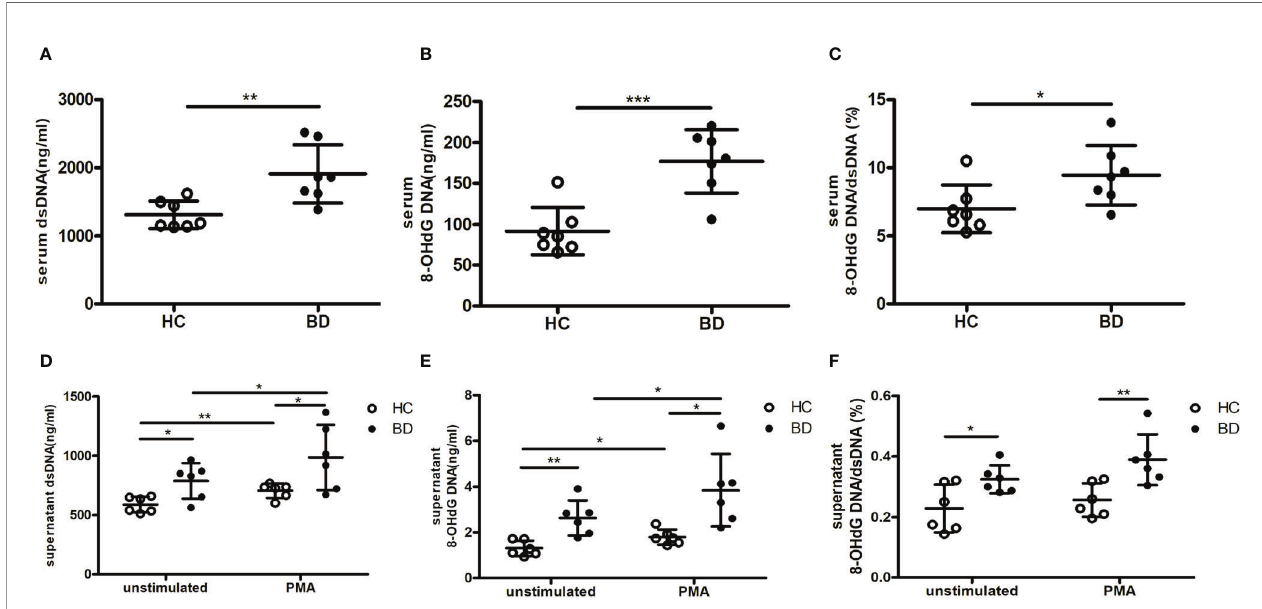
FIGURE 4 | BD neutrophil extracellular traps (NETs) contain more oxidized DNA. Serum (A) dsDNA and (B) 8-OHdG DNA from HC (n = 7) and BD (n = 7). (C) The percentage of 8-OHdG DNA in dsDNA from HC (n = 7) and BD (n = 7) serum. Supernatant (D) dsDNA and (E) 8-OHdG DNA produced by unstimulated and PMA- stimulated HC neutrophils (n = 6) and BD neutrophils (n = 6). (F) The percentage of 8-OHdG DNA in dsDNA from unstimulated and PMA-stimulated HC neutrophils (n = 6) and BD neutrophils (n = 6). Bars indicate mean value and Standard Deviation. Student ’ s t-test (A – F) and paired t-test (D, E) were applied. *p < 0.05, **p < 0.01, ***p < 0.001. BD, Behc ̧ et ’ s disease; HC, healthy controls; ns, not signi fi